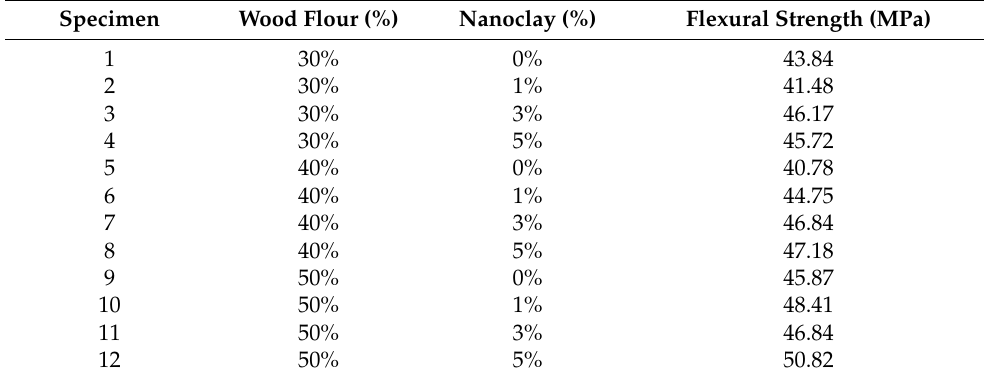
Table 9. The flexural strength according to the amount of nanoclay.